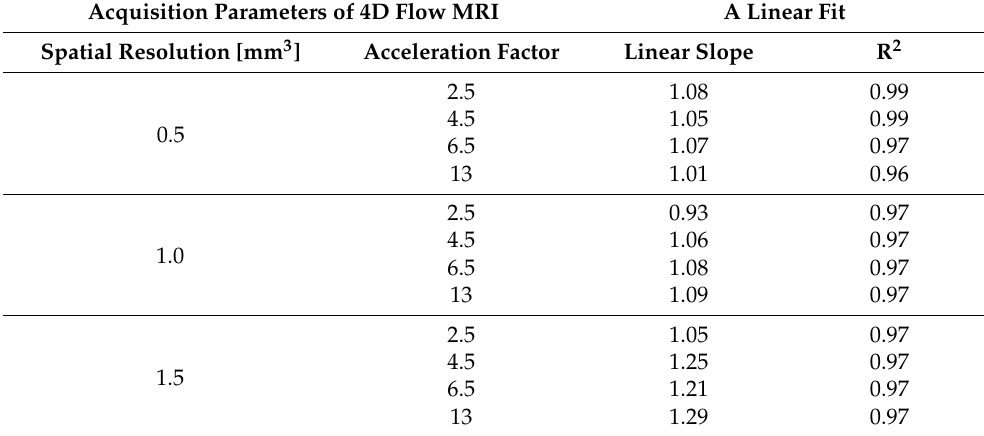
Figure 3. Scatter plots and Spearman-rank correlation coefficient between time-resolved net flow rate values obtained by 2D and 4D flow MRI in silicone tubes. A strong correlation was observed for all voxel sizes and acceleration factors (rho > 0.97). Table 2. Parameters of linear fit calculated for flow values acquired with 2D and 4D flow MRI data in silicone tubes. The linear slope was close to 1 for most 4D flow MRI parameters. The flow was overestimated (linear slope > 1.21) by 4D flow MRI acquired with 1.5 mm 3 spatial resolution and accelerated by factors of 4.5 to 13.